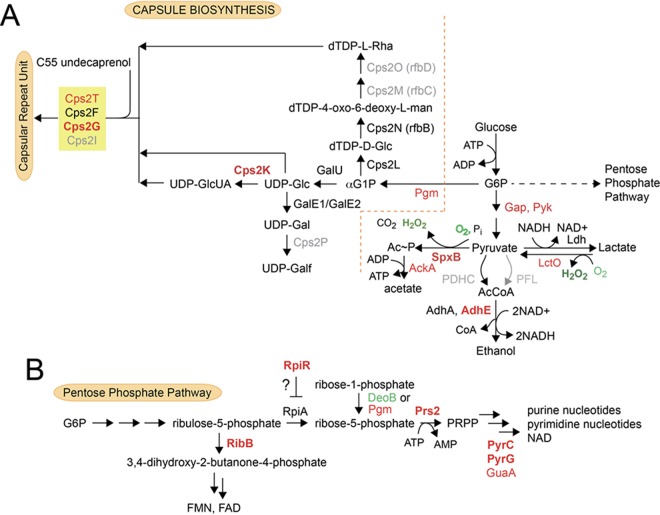
Schematic illustration of polysaccharide capsule biosynthesis (A) and nucleotide/cofactor biosynthesis (B) in S. pneumoniae D39 and its relationship to glycolysis and the fate of pyruvate under aerobic conditions. The enzymes that are found to be sulfenylated (eR ≥ 1.6, GapA) are highlighted in red, with bold red corresponding to those proteins with eR ≥ 3.0. Black indicates protein was detected in the total cell lysate, but not enriched, and gray indicates the protein was not detected in the cell lysate. Two of the three glycosyltransferases known to be involved in the synthesis of the capsule repeat unit (Cps2T and Cps2G; Cps2F is just below eR for GapA [Fig. 5C]) (65) and CpsK are all identified as sulfenylated in cells with high confidence. In panel B, key enzymes associated with synthesis and utilization of ribose-5-phosphate and sulfenylated in cells are indicated, as highlighted in panel A. Green indicates S-glutathionylated in the cell lysate (DeoB).